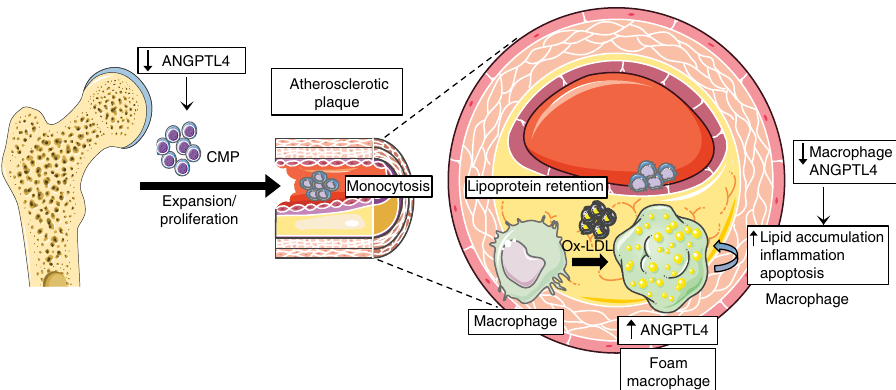
Figure 8 | ANGPTL4 deficiency results in monocytosis and massive atherosclerosis. Schematic diagram showing haematopoietic ANGPTL4 function in atherosclerosis. ANGPTL4 is induced in macrophages in response to lipoprotein loading. ANGPTL4 deficiency in macrophages results in increase in foam cell formation, inflammation and apoptosis of macrophages within atherosclerotic plaques. Concomitantly, ANGPTL4 deficiency in haematopoietic cells results in an increase in the frequency and survival of CMPs, and upon WD feeding results in an elevated level of circulating monocytes. Overall,